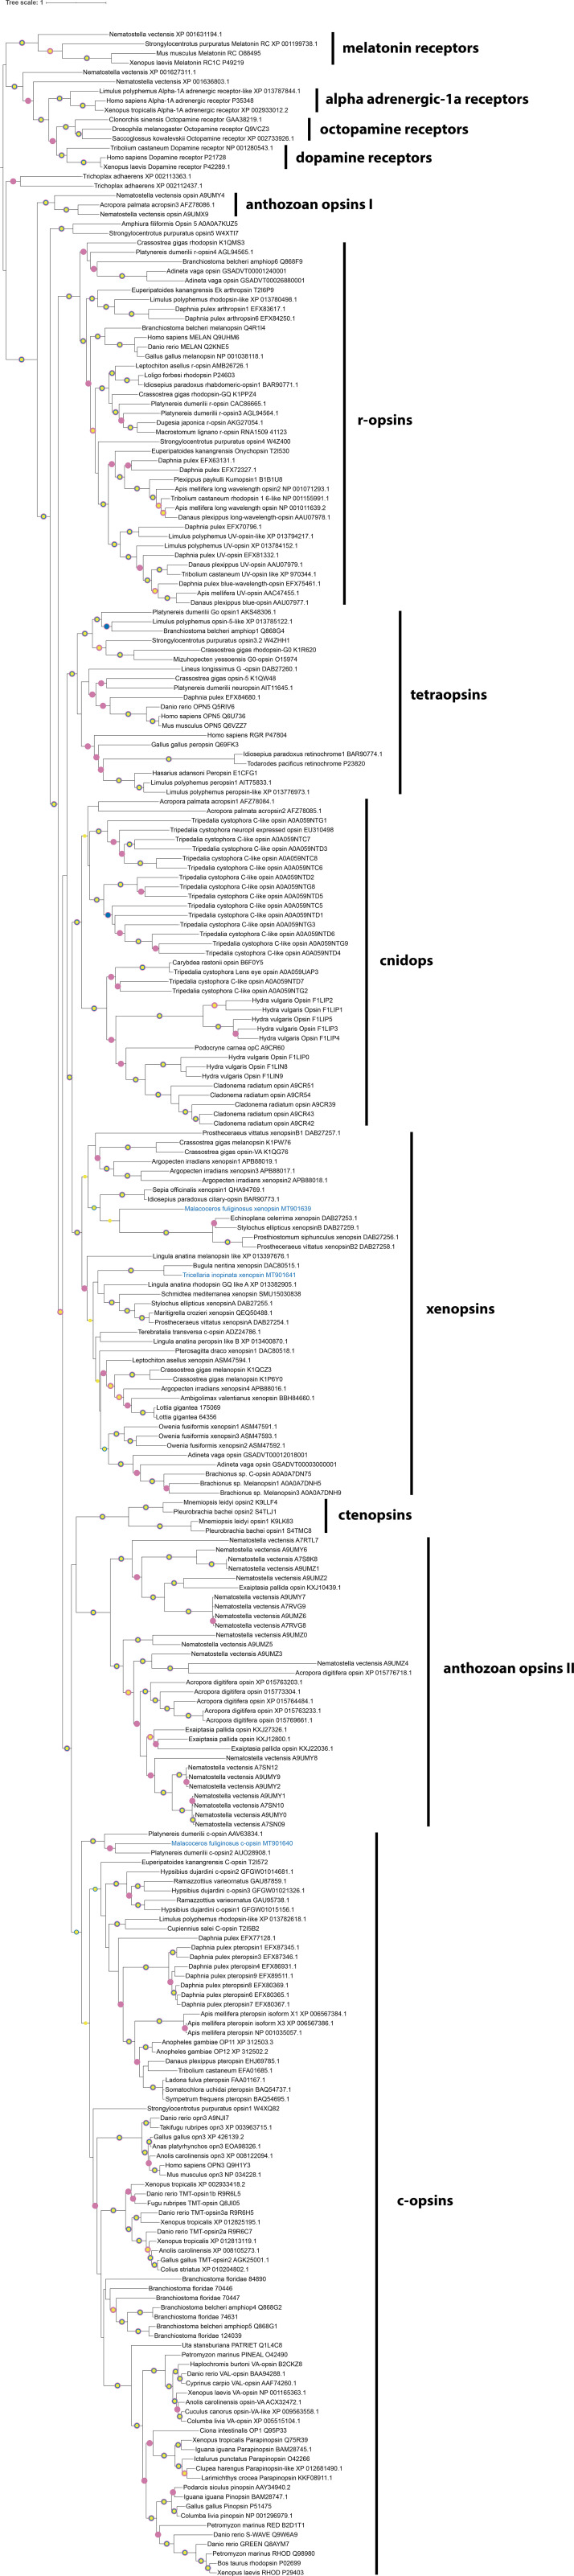
Un-collapsed tree of phylogeny shown in Figure 2.Maximum Likelihood tree (IQ-TREE, LG+F+R8). Labeled nodes have support values of approximate Bayes test ≥0.98 (yellow dot), SH-like approximate likelihood ratio test ≥90 (blue dot) and ultrafast bootstrap ≥90 (purple dot). The sequences investigated in this study are highlighted in blue.